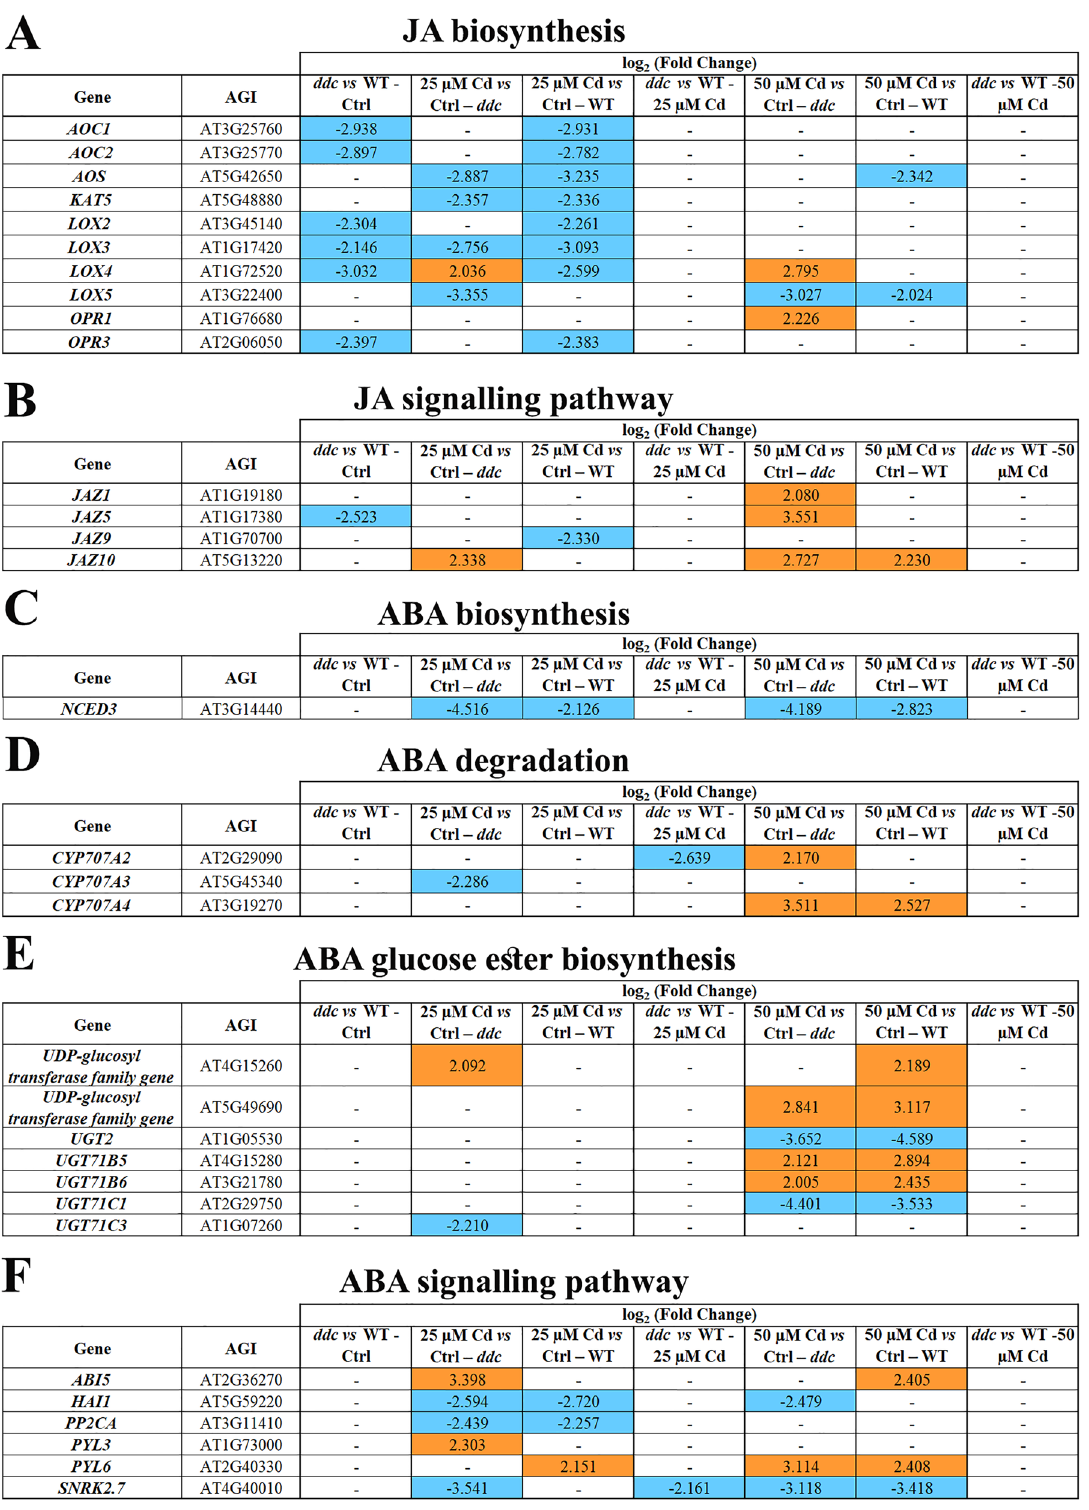
Figure 5. Genes differentially expressed (DEGs) along the pathway of ( A ) JA biosynthesis, ( B ) JA signalling, ( C ) ABA biosynthesis, ( D ) ABA degradation, ( E ) ABA glucose ester biosynthesis and ( F ) ABA signalling in ddc and WT plants identified through a transcriptomic approach. For each comparison, the log 2 (fold change) of the analysed DEGs was shown in orange and in blue for the upregulated and downregulated genes, respectively. Plants were grown for 21 DAG in long day condition: (i) on growth medium added with 25 or 50 µM Cd; (ii) on growth medium without Cd as control